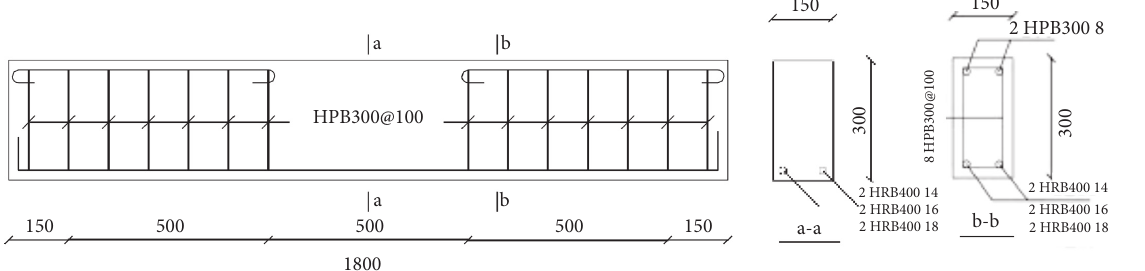
Figure 1: Reinforcement details of test beams (mm).